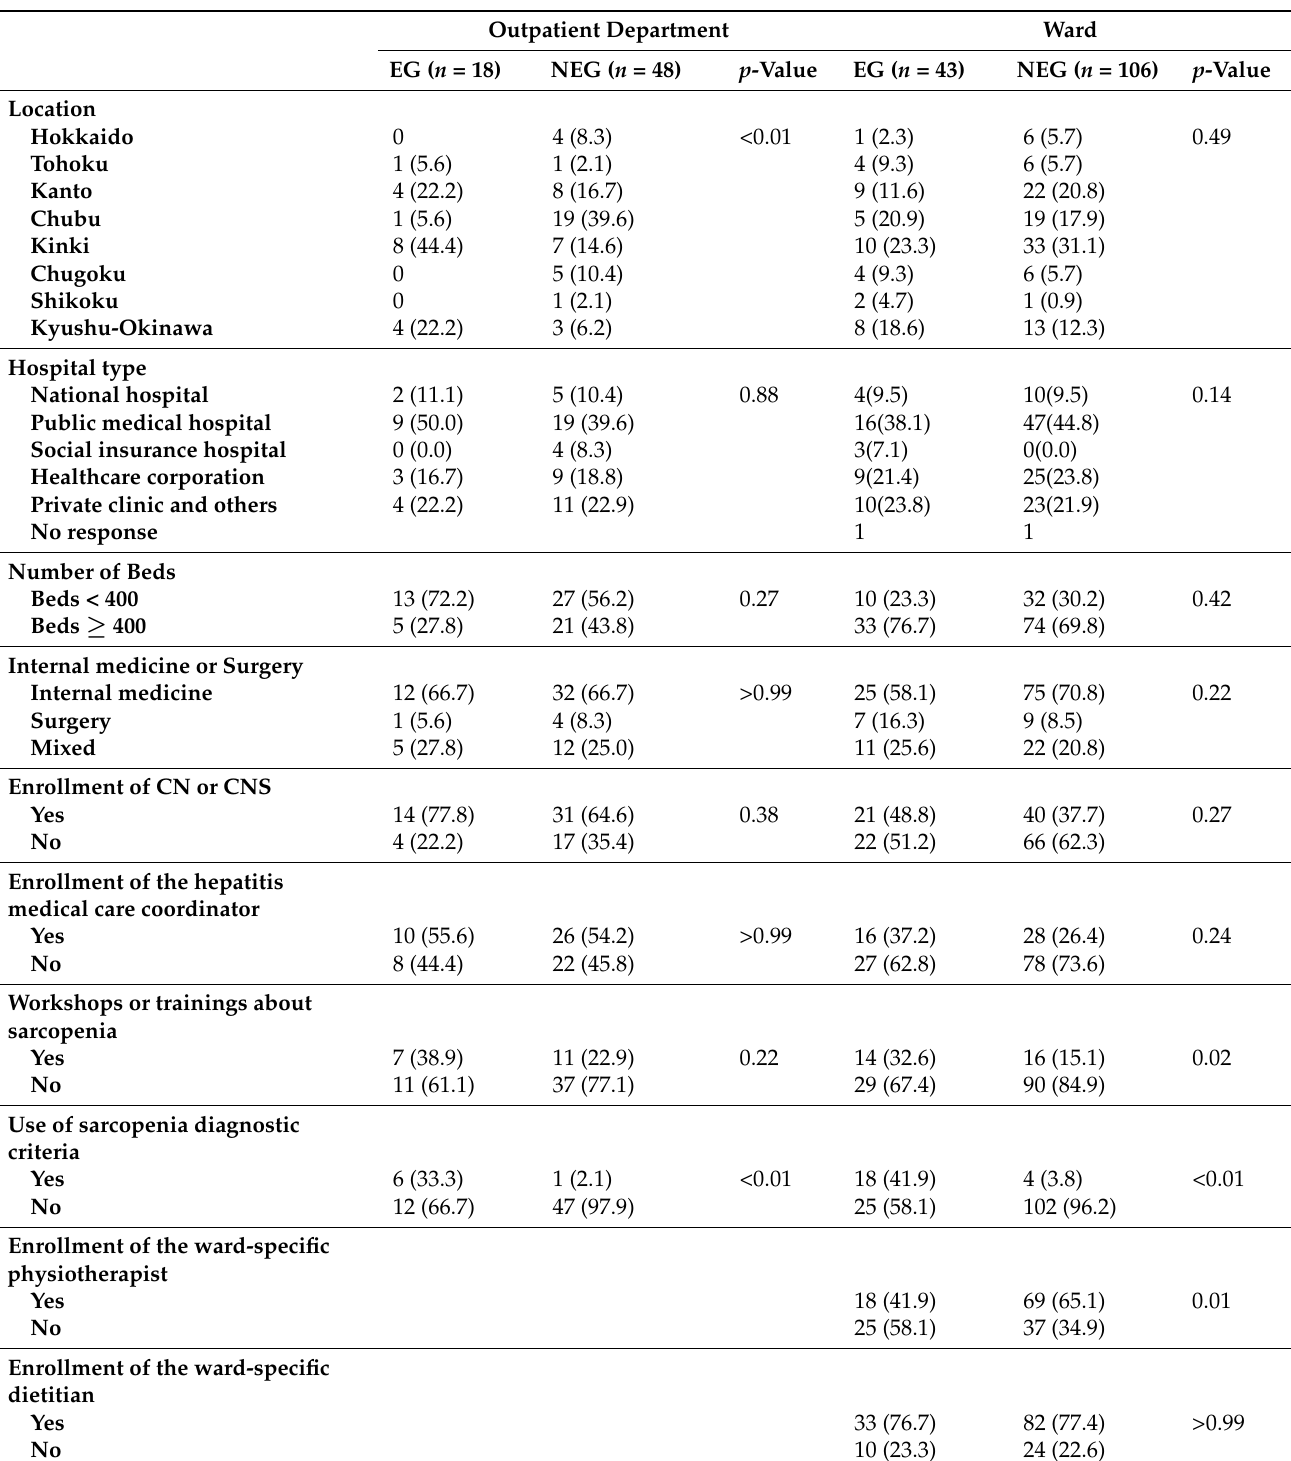
Table 4. Comparison between evaluate group and non-evaluate group in outpatient department and